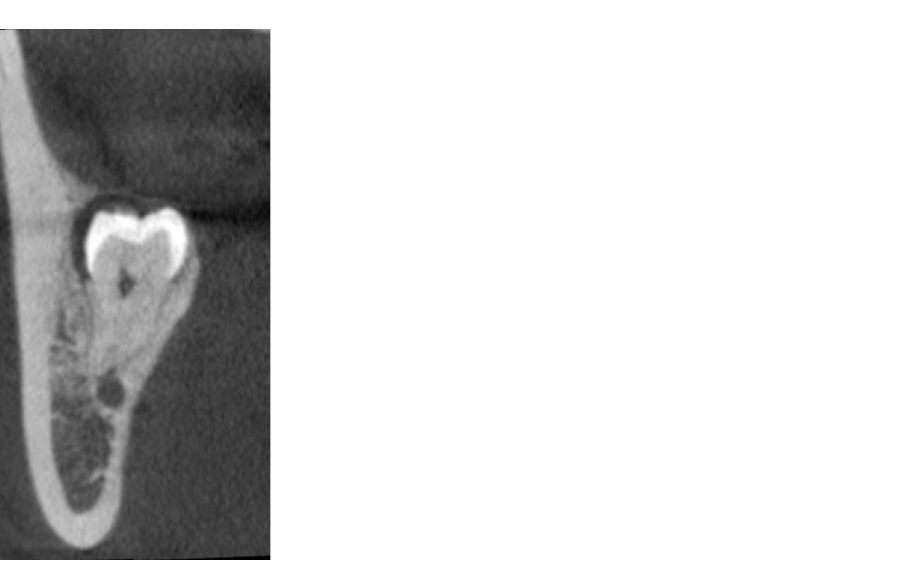
Figure 2. Representative CBCT image showing the loss of the upper cortex of the inferior alveolar